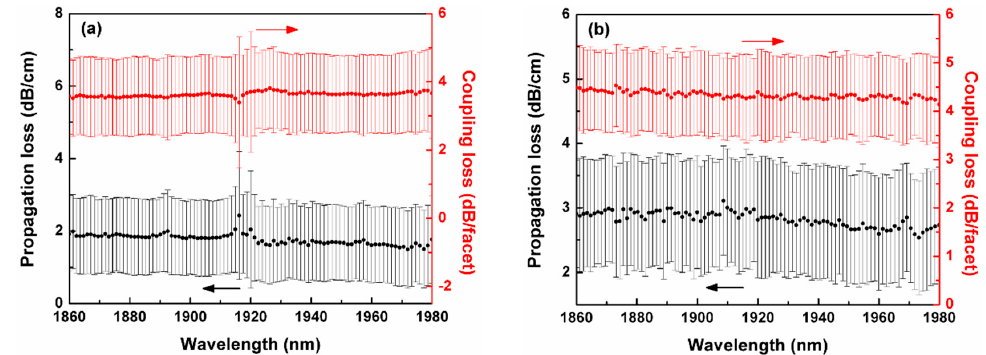
Figure 2. The measured propagation loss and coupling loss with respect to the wavelength for the fabricated silicon-rich nitride ridge waveguides with ( a ) h = 380 nm and w = 950 nm and ( b ) h = 640 nm and w = 1320.